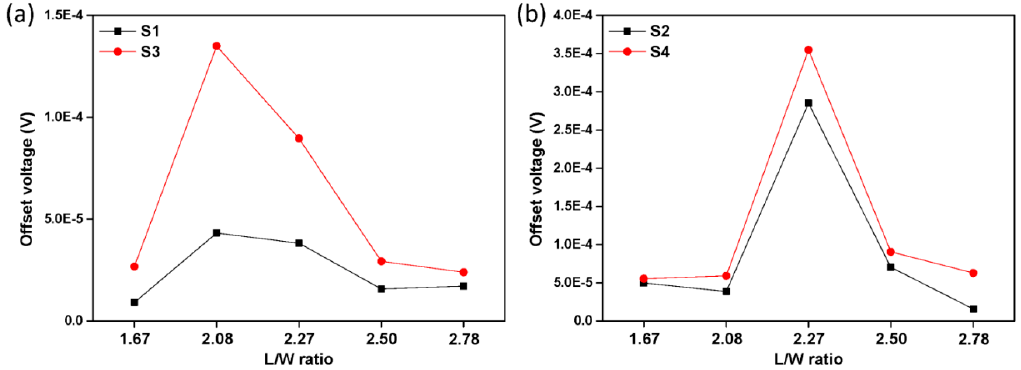
Figure 8. ( a ) Measured offset voltage versus the L/W ratio of S1, S3; ( b ) Measured offset voltage versus the L/W ratio of S2 and S4.